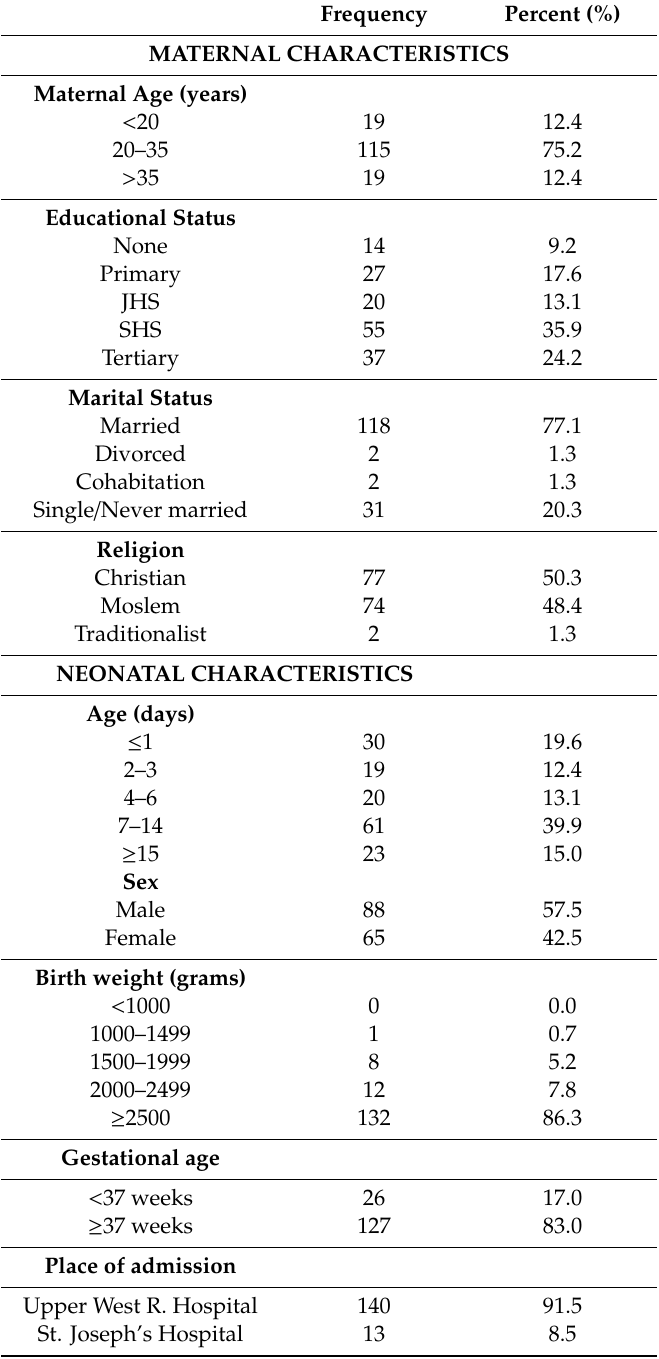
Table 1. Characteristics of outborn neonates and their